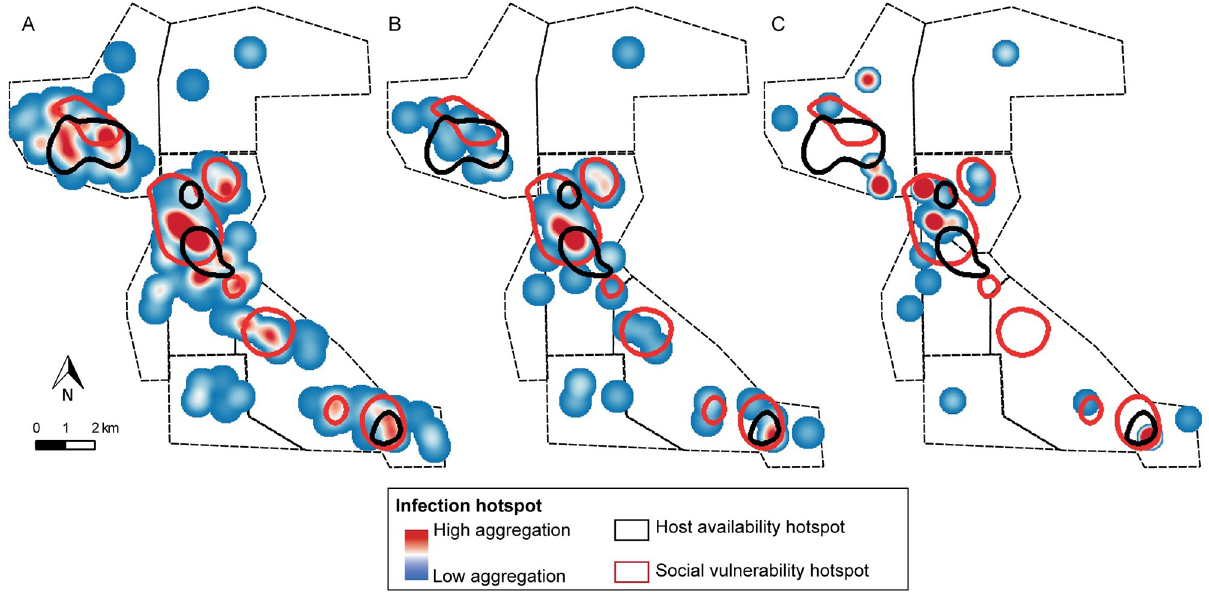
Fig 5. Heatmaps of the household number of T . cruzi -seropositive people (A) and children (B), and the relative abundance of T . cruzi -infected T . infestans per unit of effort (B) in 2008, prior to a community-wide insecticide spraying campaign, Pampa del Indio, Argentina. The areas of qualitative aggregation (as determined by heatmaps) of social vulnerability and host availability are also shown. The maps were created in QGIS 2.18.11. based on the data collected within the scope of this study (S4